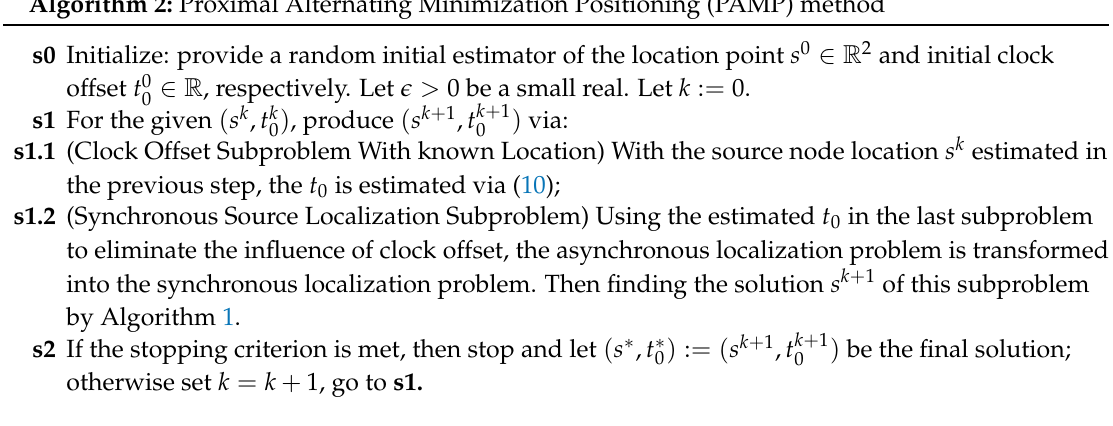
Algorithm 2: Proximal Alternating Minimization Positioning (PAMP)